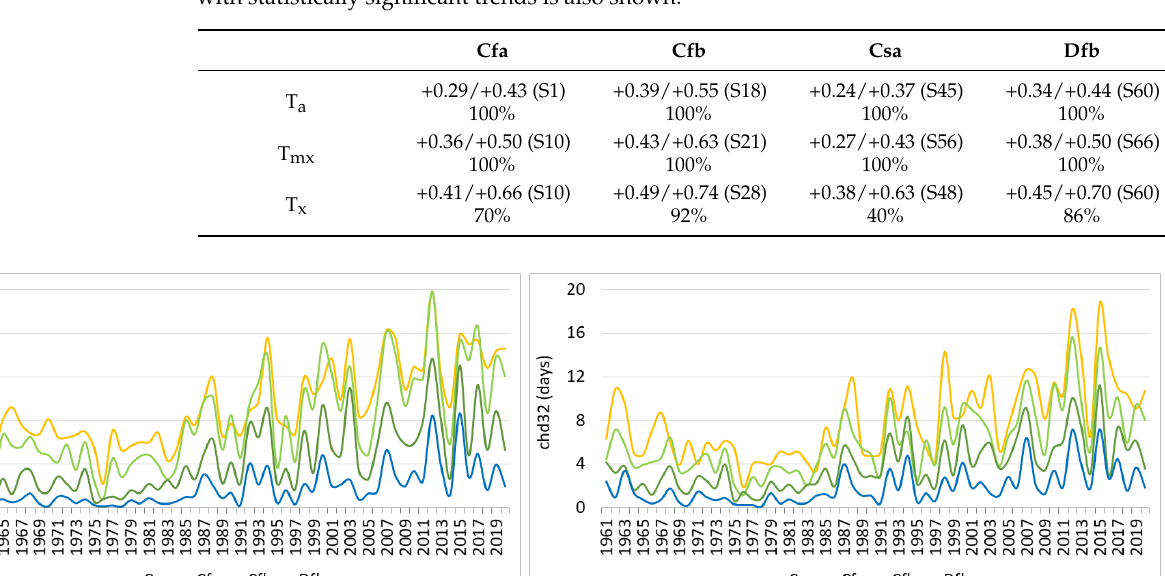
Table 1. Average/maximum values of Sen’s slope estimates (unit: °C/10 years) of statistically